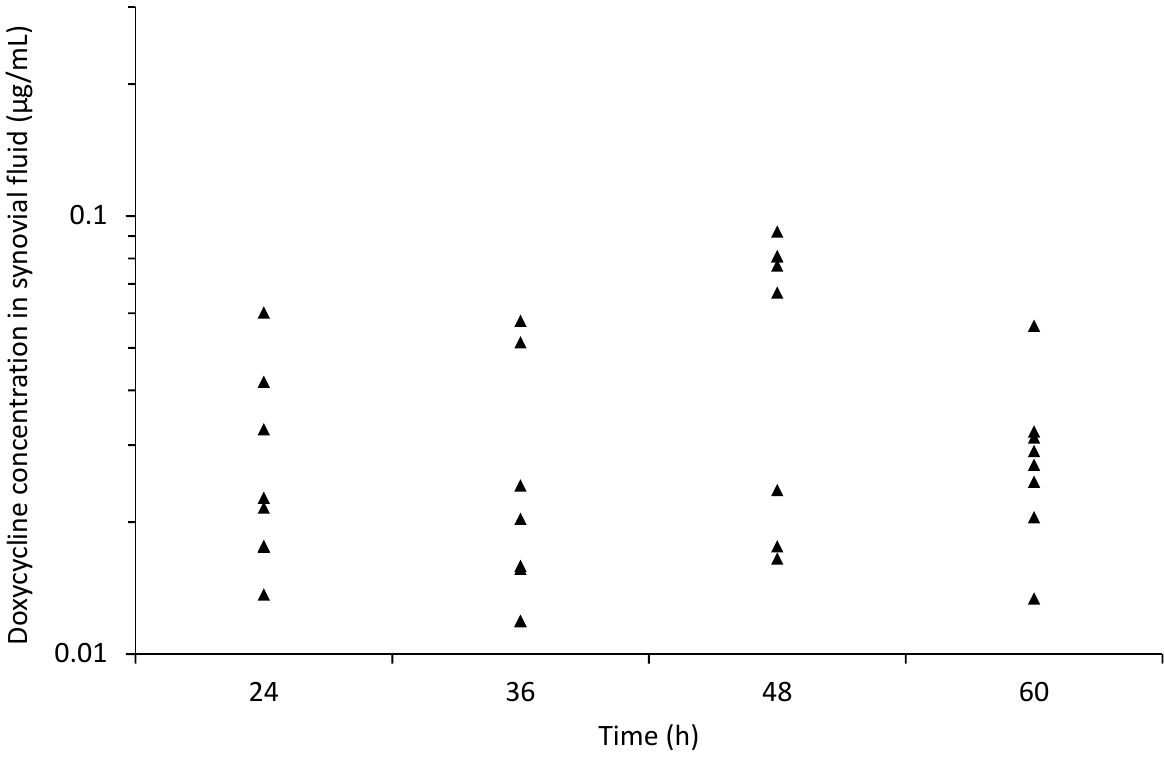
Figure 5. Individual concentration of doxycycline in urine vs. time during intragastric administration of doxycycline at 10 mg/kg q12 h from 0 to 48 h in 8 healthy jennies. Each solid diamond represents the value from one jenny at each time point.